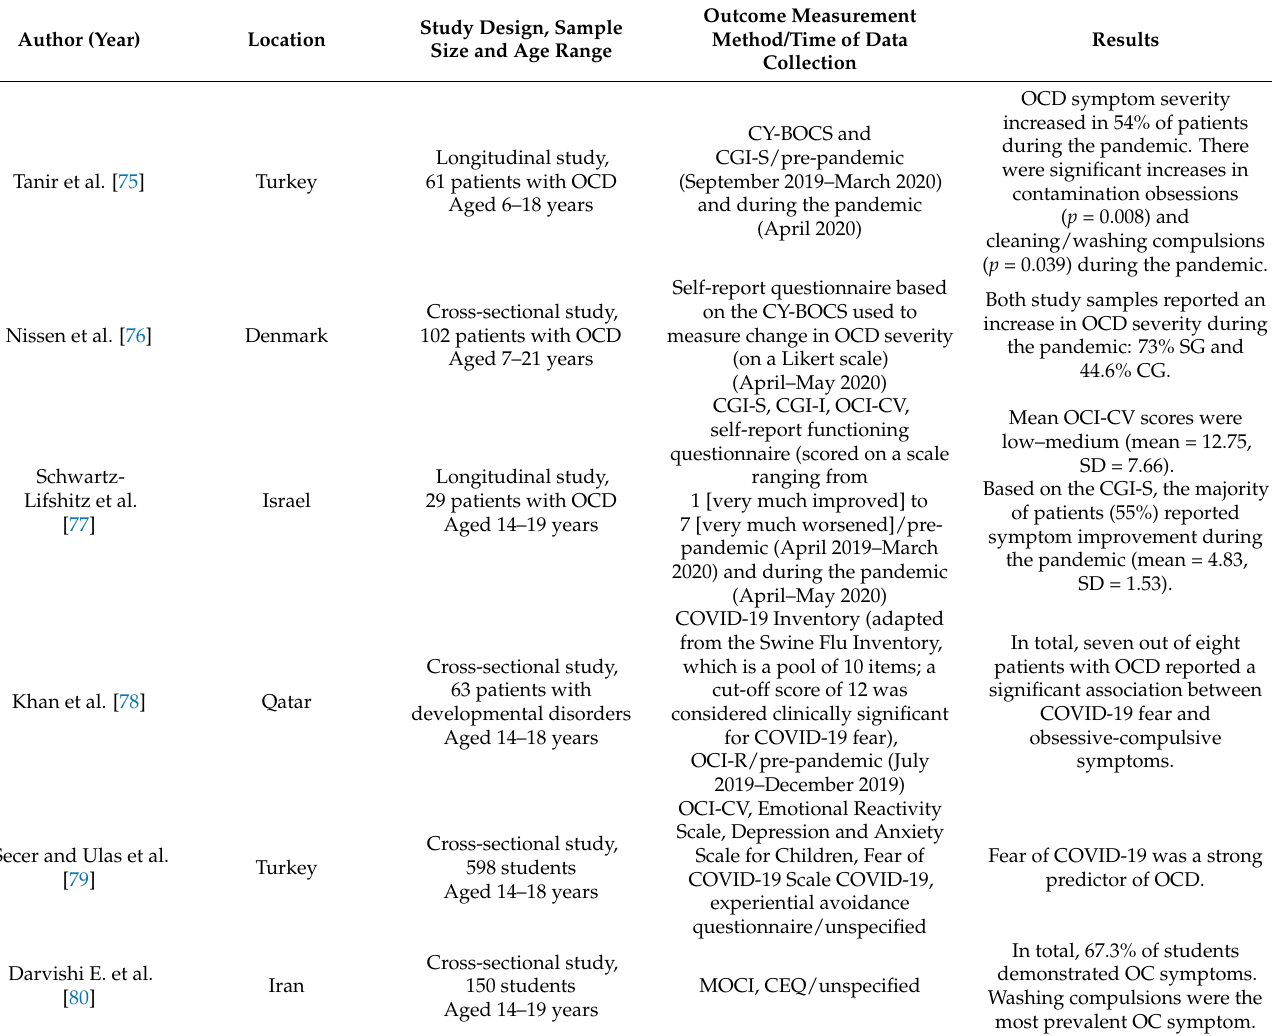
Table 2. Study findings of the effect of COVID-19 on OCD and OC symptoms in young